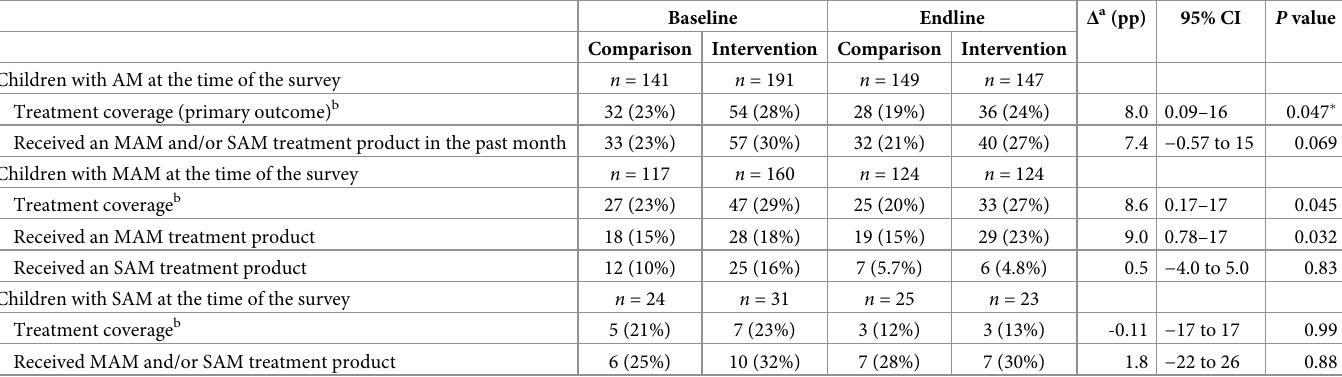
Table 4. Effect of the intervention on AM treatment coverage assessed by cross-sectional study. Baseline P value Comparison Intervention Comparison Intervention